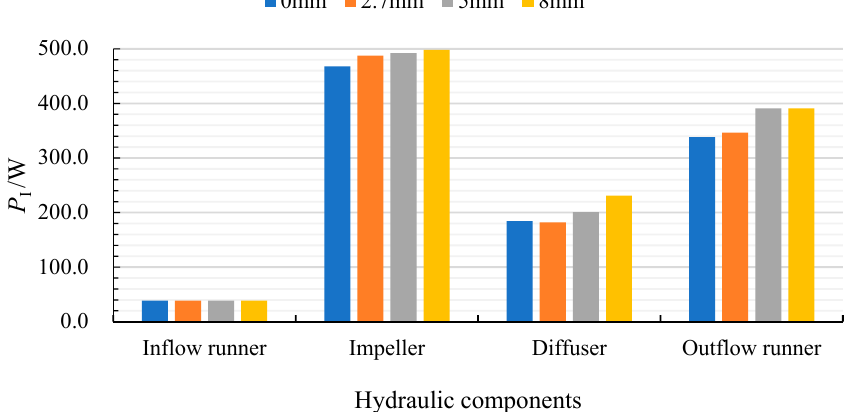
Figure 9. Distribution of power loss due to indirect dissipation at 1.0 Q des for varying root clearances (R t = 0 mm, 2.7 mm, 5 mm, 8 mm).